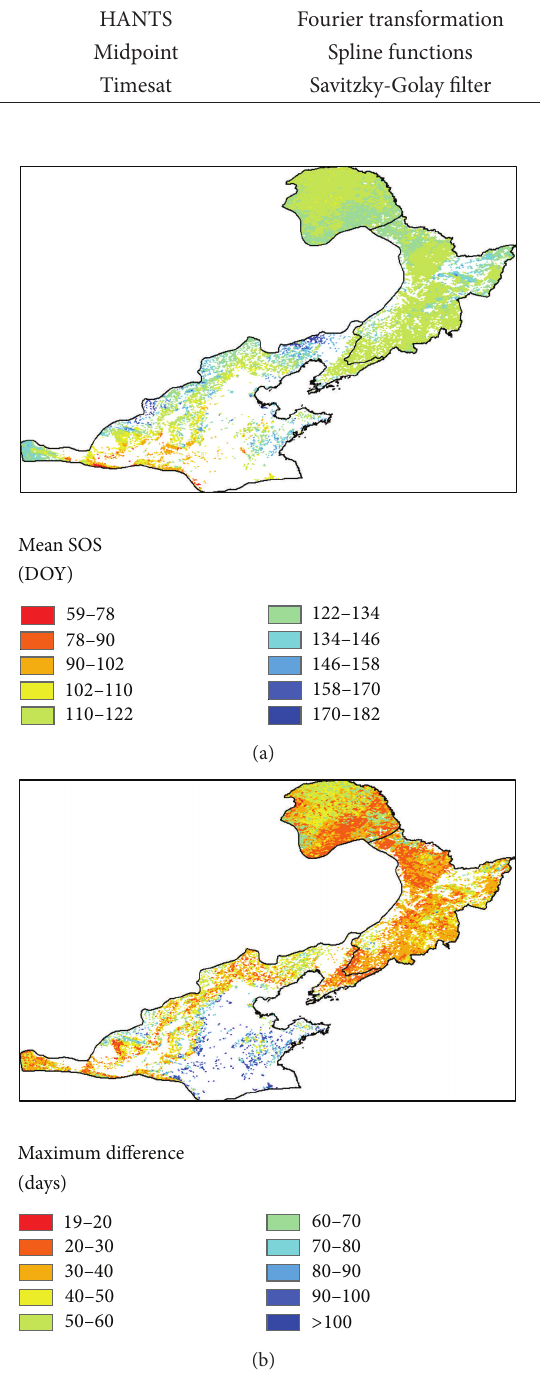
Figure 2: (a) The start of season (SOS) averaged from the results of the five methods in the 1982–2006 period and (b) the maximum difference between the five satellite-derived SOS measurements.